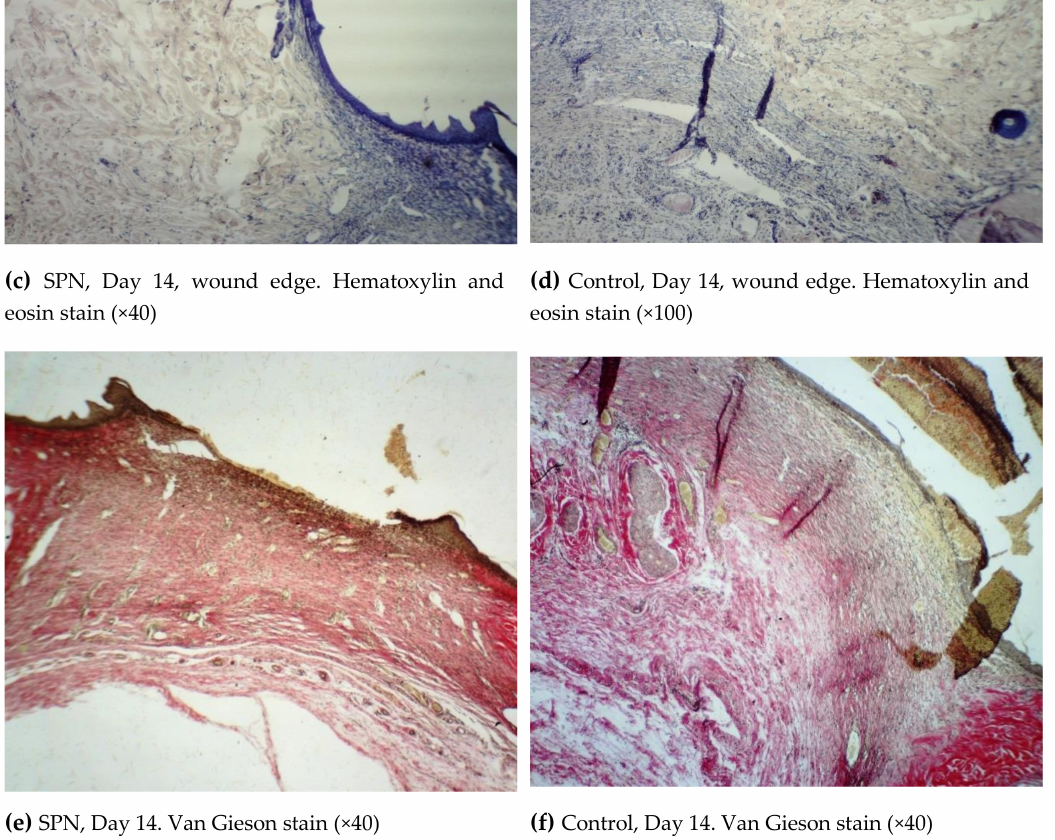
Figure 5. Morphological patterns of the SPN group wounds ( a , c , e ) and the control group wounds ( b , d , f ) on Day 14 of the